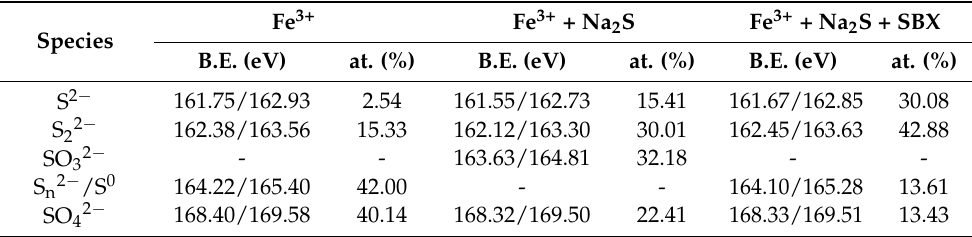
Table 5. S 2p quantification of digenite with different treatments in the presence of Fe 3+